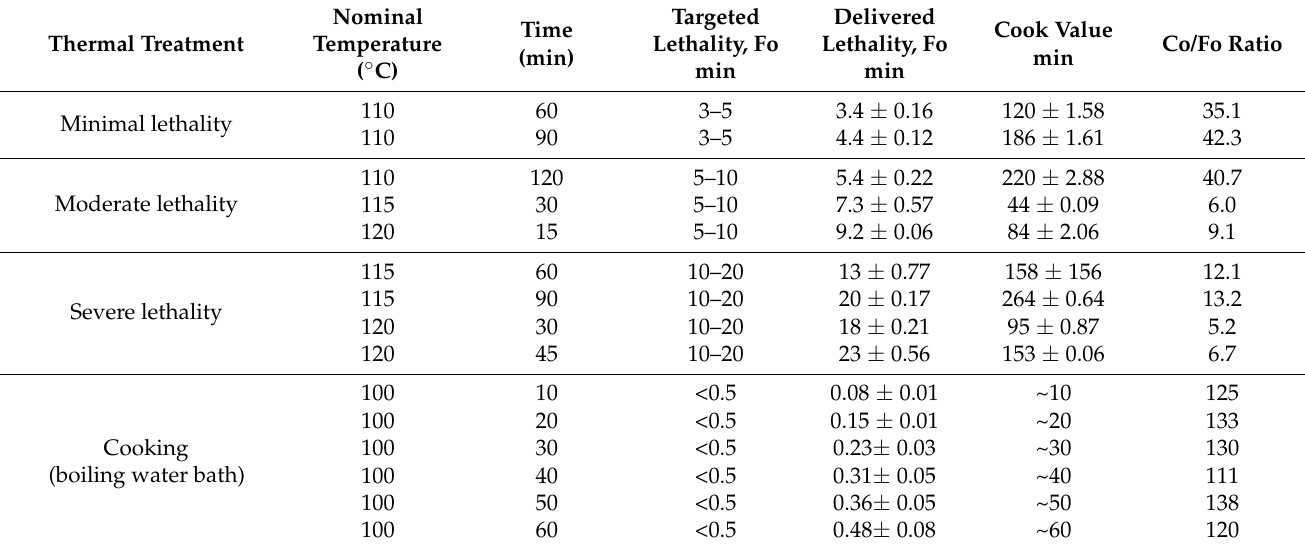
Table 1. Design of thermal processing and cooking time schedule with targeted and delivered process lethality, the resulting cook values and Co/Fo